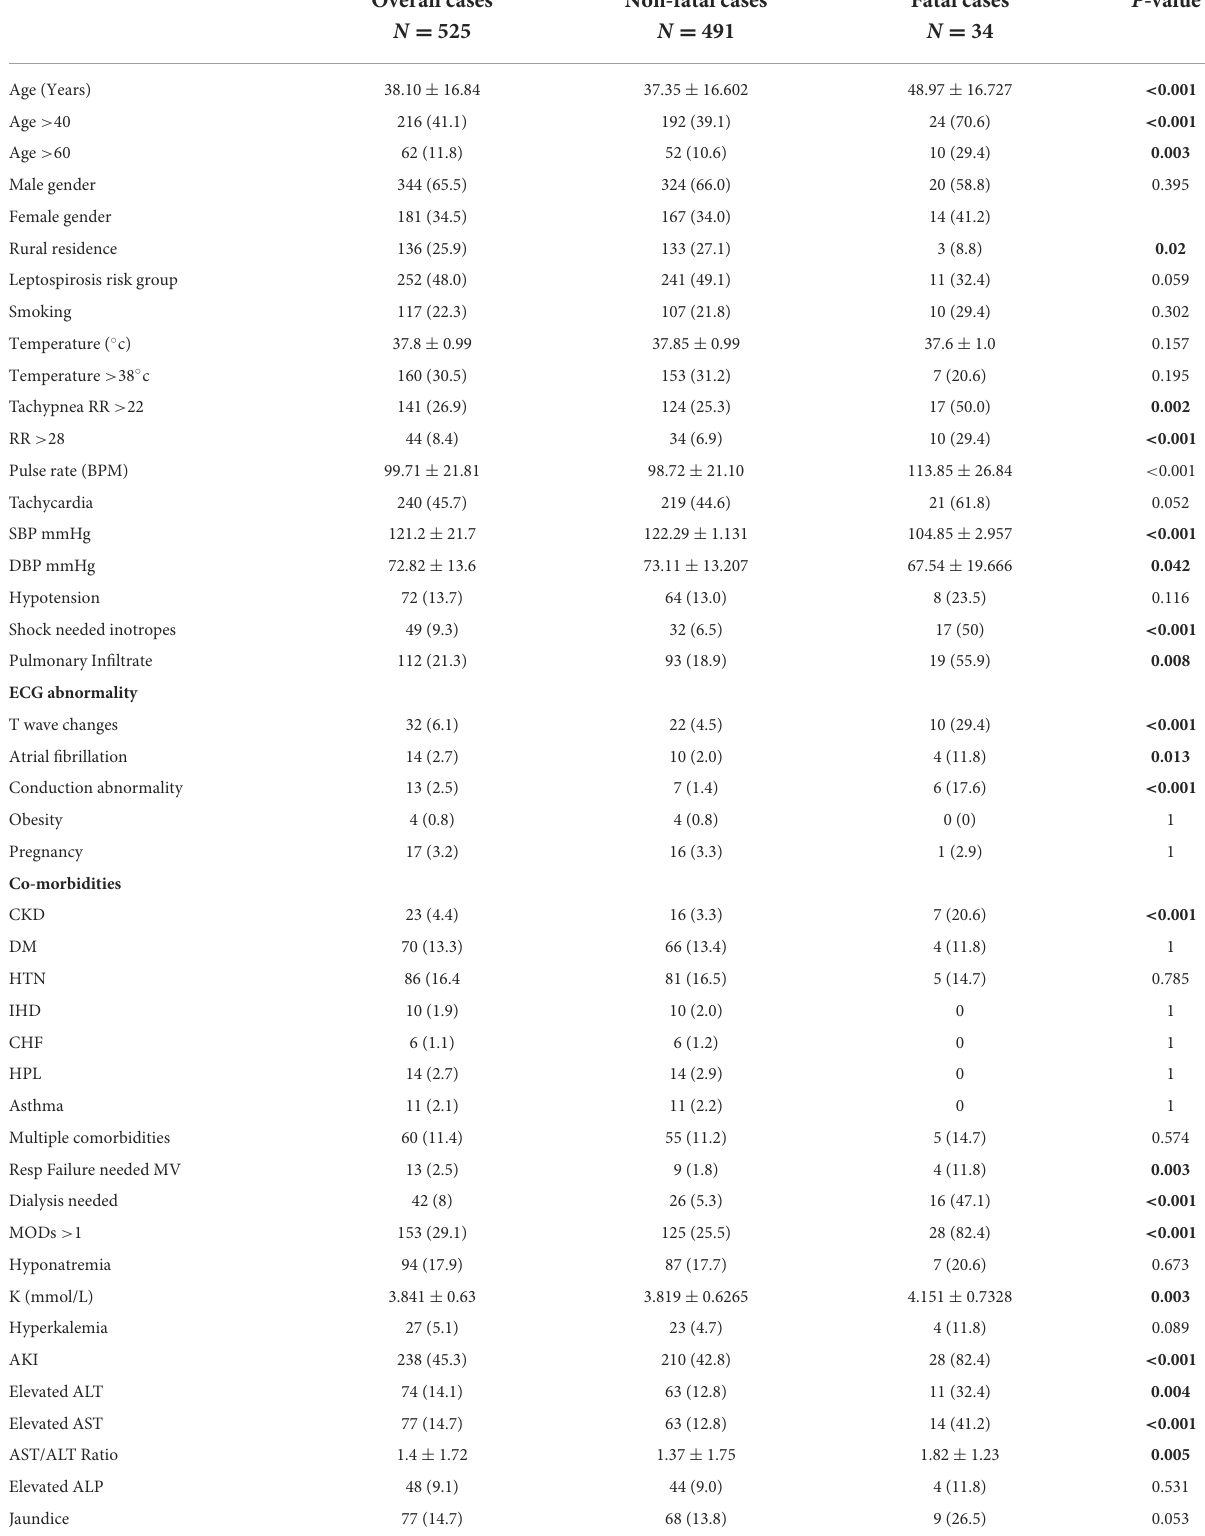
TABLE 5 Comparison of demographics and clinical characters (at baseline) between fatal and non-fatal leptospirosis